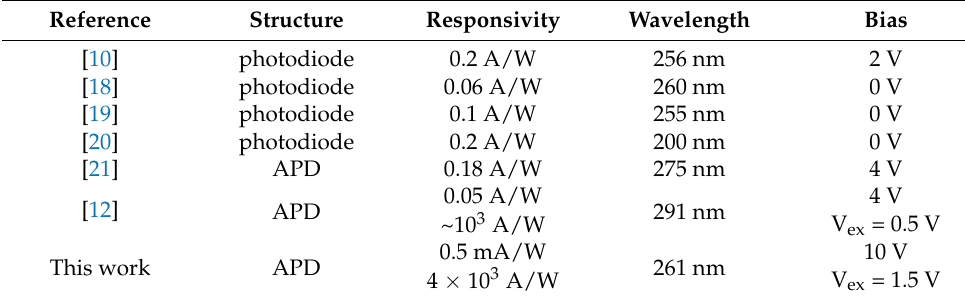
Table 1. The UV response comparison with other reported